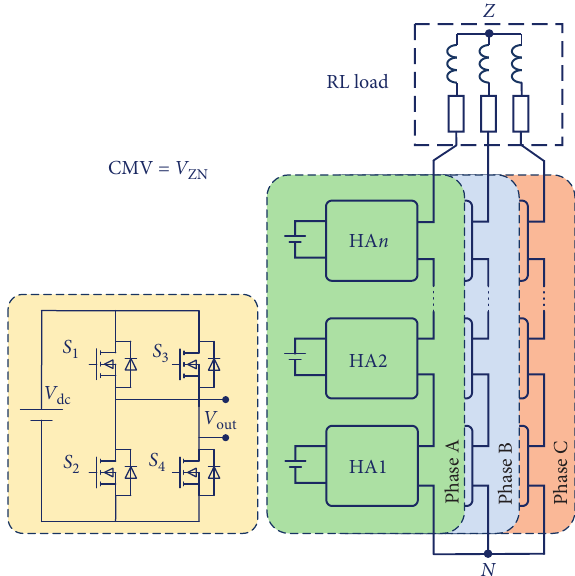
Figure 1: Cascaded H-bridge multilevel inverter.